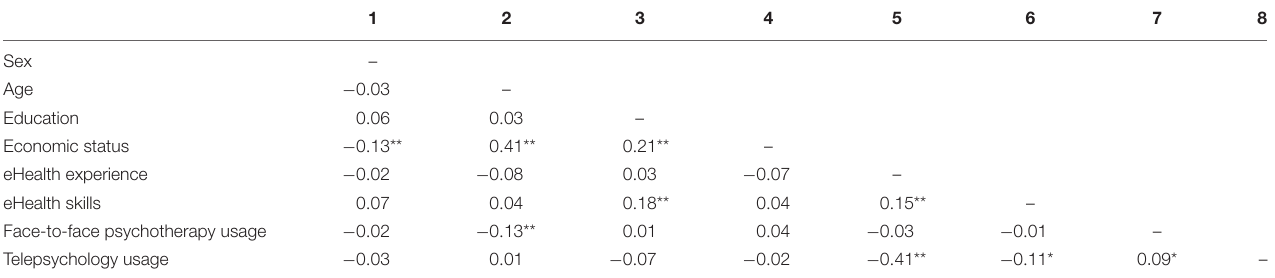
TABLE 3 | Correlation analysis.